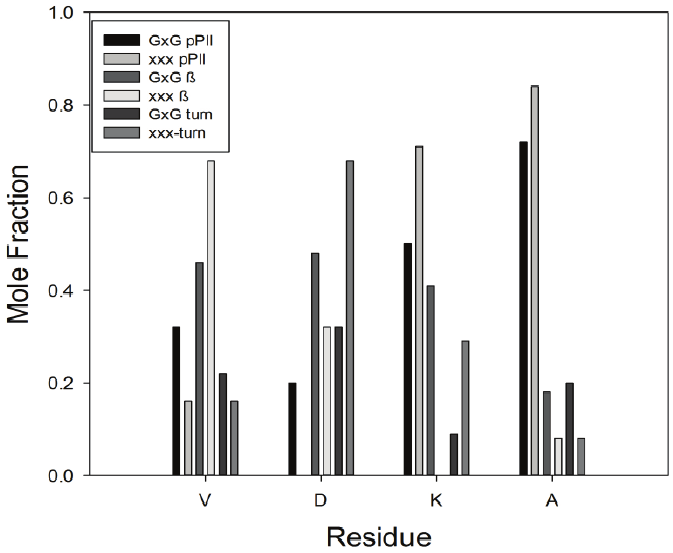
Figure 21. Representation of the molar fractions of amino acid residues indicated on the abscissa in GXG and XXX peptides. The code for the bars is defined in the inset of the figure. The data were taken from [138] for GAG, GVG, GDG and GKG and from [118,140] for AAA, VVV, protonated DDD and protonated